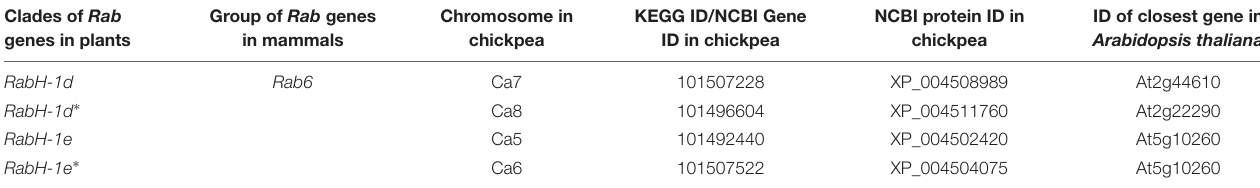
shared with CaRabC-1a, while CaRabC-2a and CaRabC-2a ∗ were the most diverged from all others ( Figure 2